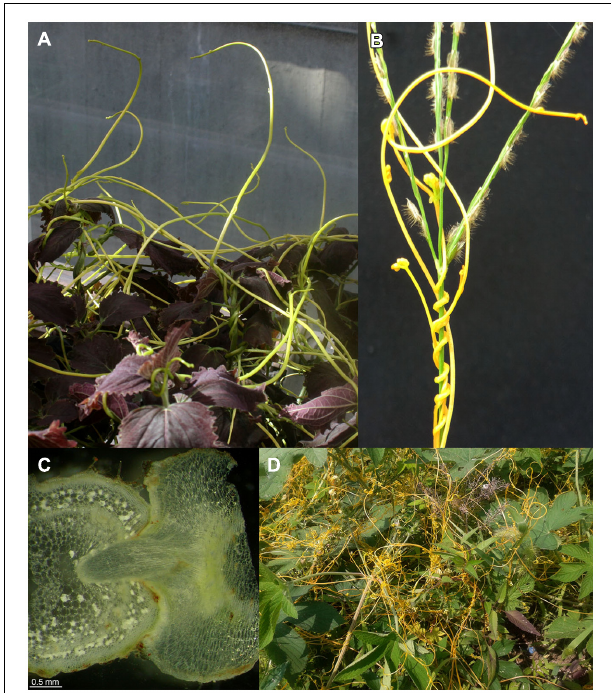
FIGURE 1 | Cuscuta spp. on susceptible host plants. (A) Cuscuta reflexa on Coleus blumei ; cultivation in the greenhouse, University ofTübingen. (B,D) Cuscuta australis near Daejin-University, Pocheon, South Korea. (B) C. australis infecting a grass (monocotyledon). (C) Cross section of a C. reflexa haustorium growing into the shoot of a susceptible host plant ( Nicotiana benthamiana ) (D) C. australis on a dicotyledonous host